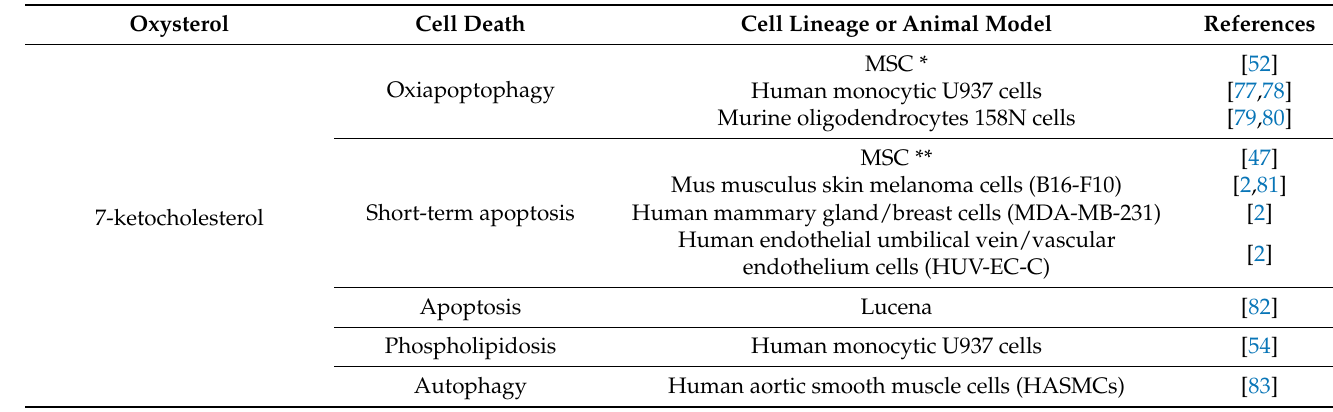
Table 2. Oxysterols and cell